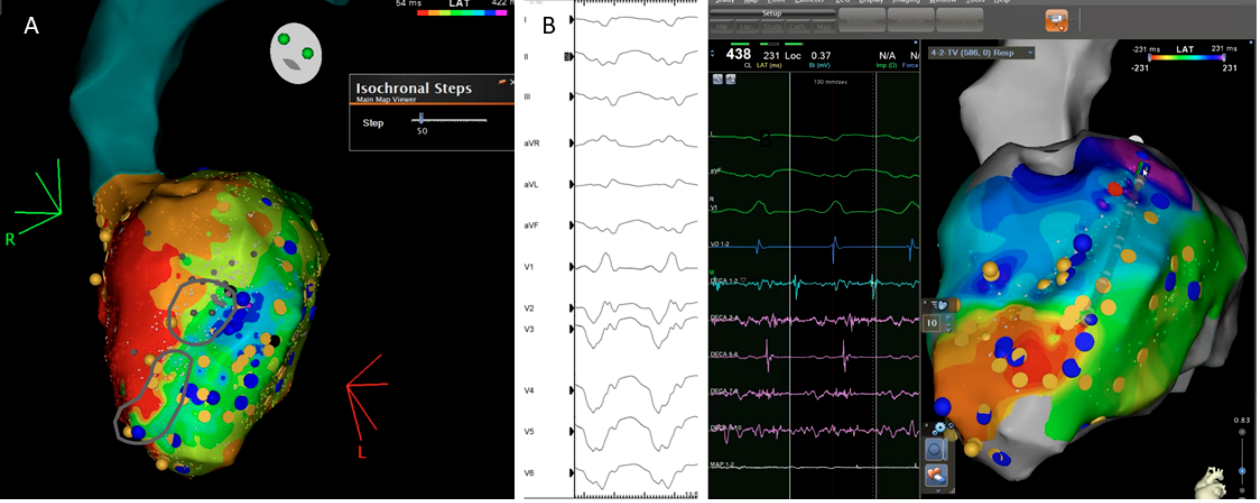
Figure 5. Correlation between the ventricular tachycardia (VT) circuit with critical diastolic pathway ( A ) and deceleration zone (DZ) location during sinus rhythm as depicted during ILAM mapping ( B ). Late isochronal activation map is shown in the left side of the panel (8 isochrones). Two deceleration zones are observed (more than 3 isochrones in less than 1 cm radius) in the anterior wall. The termination site of VT (on the right) colocalized to the DZs.